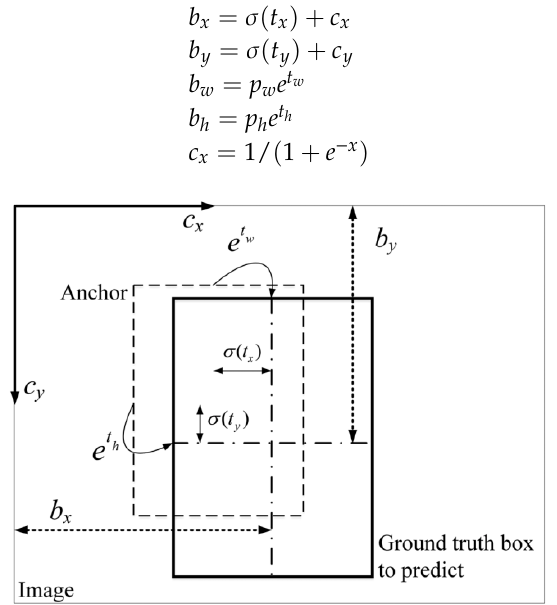
represent the offset of the grid